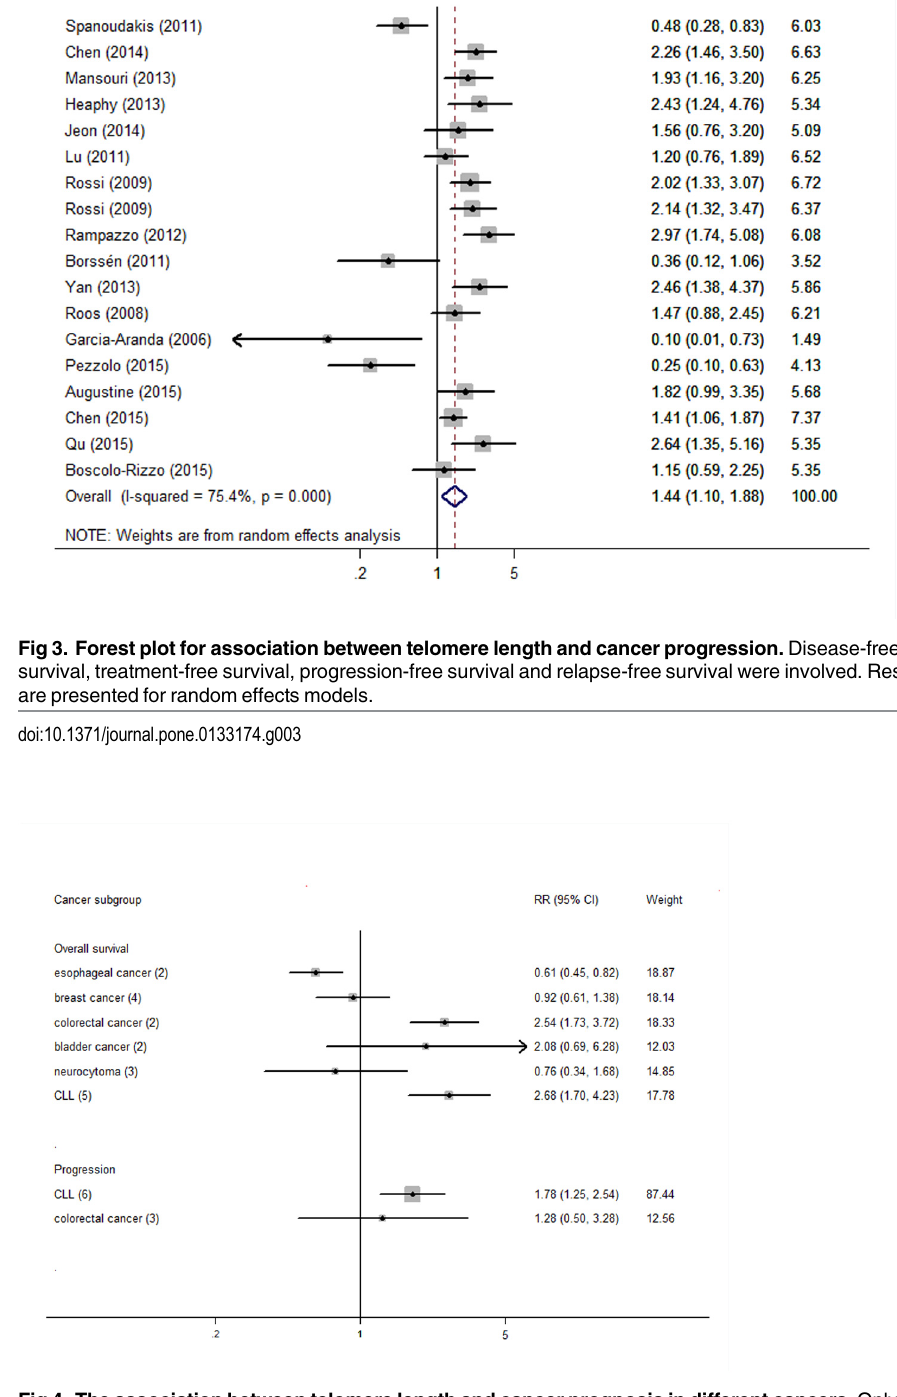
Fig 4. The association between telomere length and cancer prognosis in different cancers. Only cancer types included at least two studies are presented.